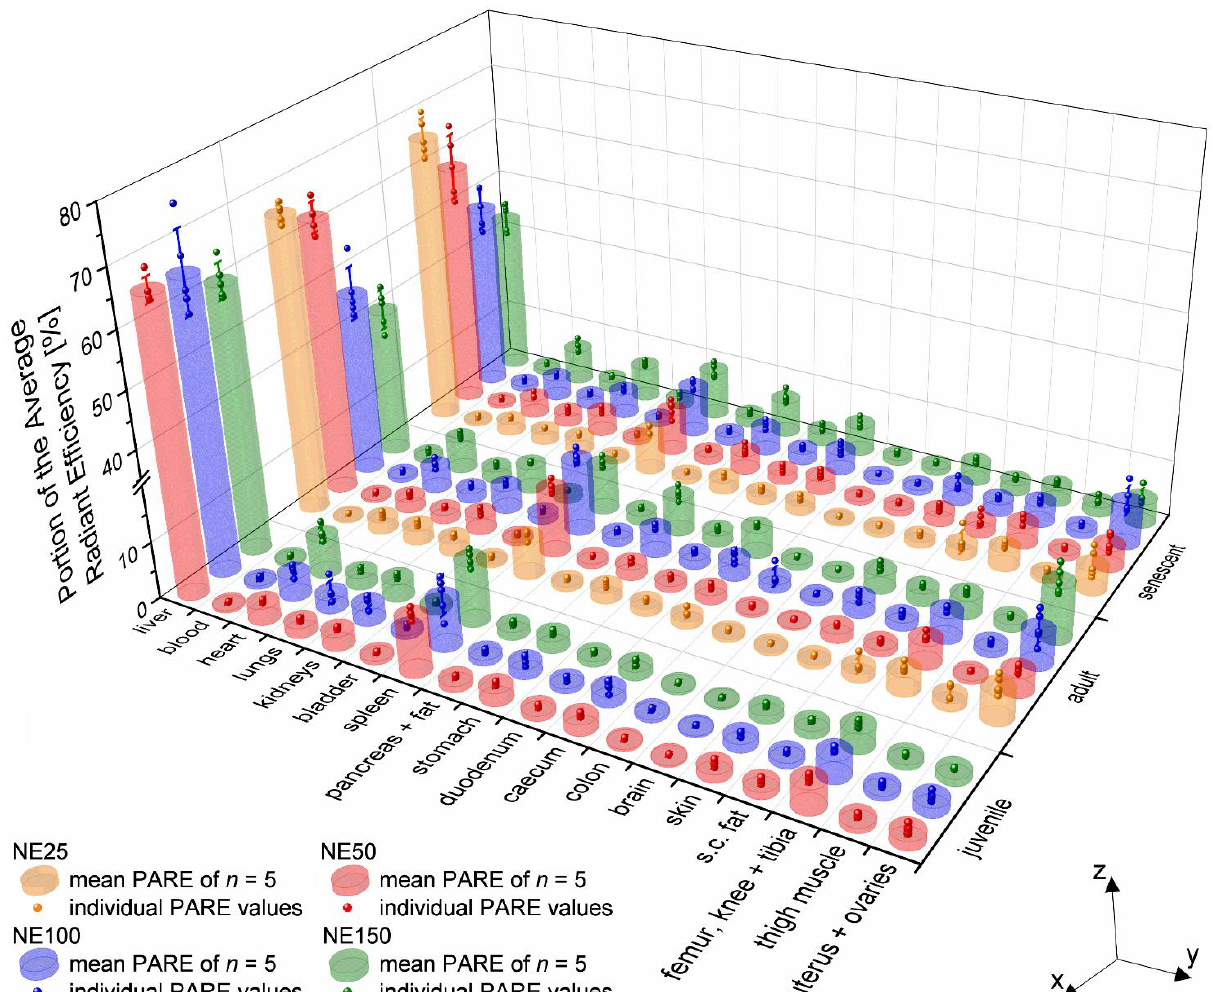
Figure 6. Combined 3D bar chart (mean PARE of the five mice per group) and scatter chart (individual PARE values of each mouse) of the ex vivo excised organs and blood, 24 h after i.v. injection of the four nanoemulsions in juvenile prepubescent (age 3 – 4 weeks), adult (age 12 – 39 weeks), and senescent mice (age > 48 weeks).